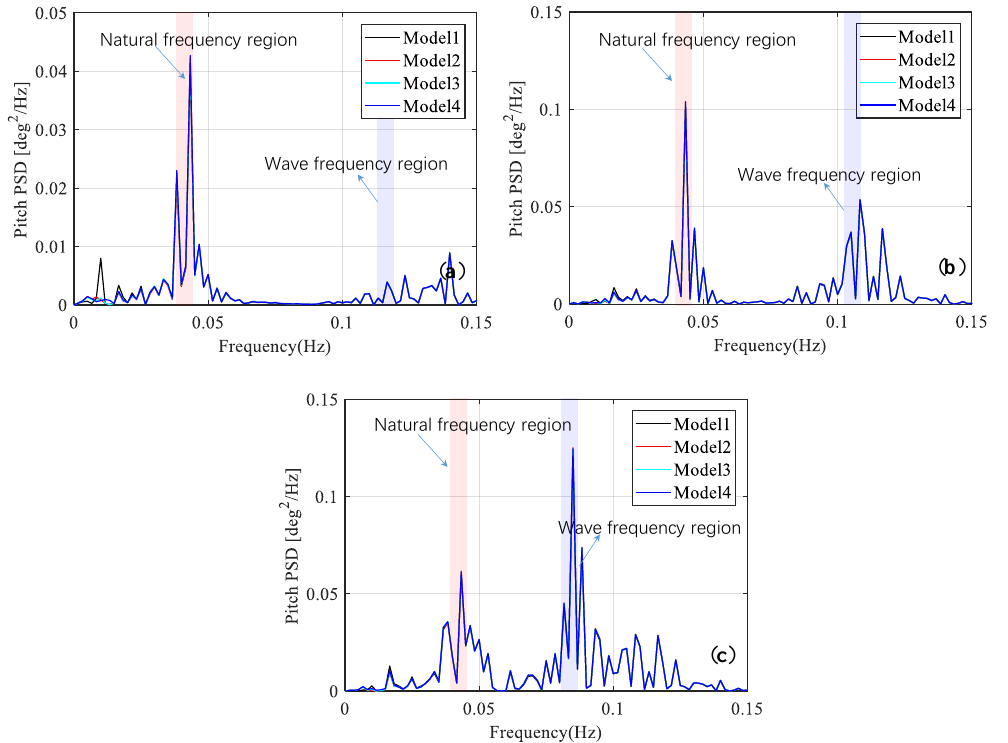
Figure 12. Frequency domain curves of the heave PSD of the multi-segmented mooring line models: ( a ) LC4; ( b ) LC5; and ( c ) LC6.